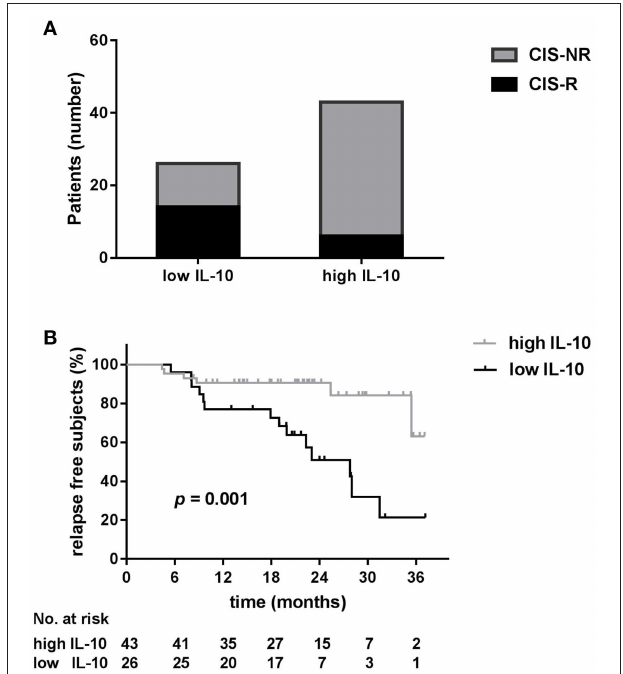
FIGURE 3 | Low serum IL-10 levels are a predictor of relapse for clinically isolated syndrome (CIS) patients. (A) There was a significantly higher proportion of patients with clinical relapse (R) during follow-up among low IL-10 ( < 1.3 pg/ml) CIS patients than among high IL-10 ( ≥ 1.3 pg/ml) CIS patients (70.0 vs. 30.0%, p < 0.001). (B) Kaplan–Meier curves show that the time to first relapse was shorter in CIS patients with low serum levels of IL-10 (log-rank, p = 0.001).